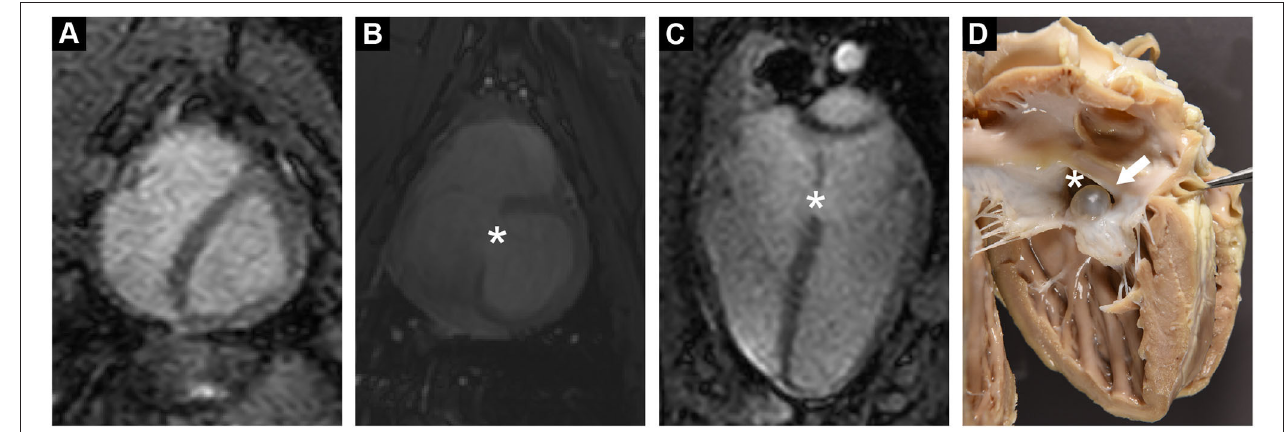
FIGURE 1 | (A) Functional cardiac MRI in short axis revealed a diastolic D-shaped left ventricle, indicating increased right ventricular pressure. (B,C) Cardiac MRI in short and long axis demonstrated a tissue defect in the inter-atrial septum (*). (D) Post mortem examination confirmed a large ASD (*). ASD was partially occluded by a serous cyst